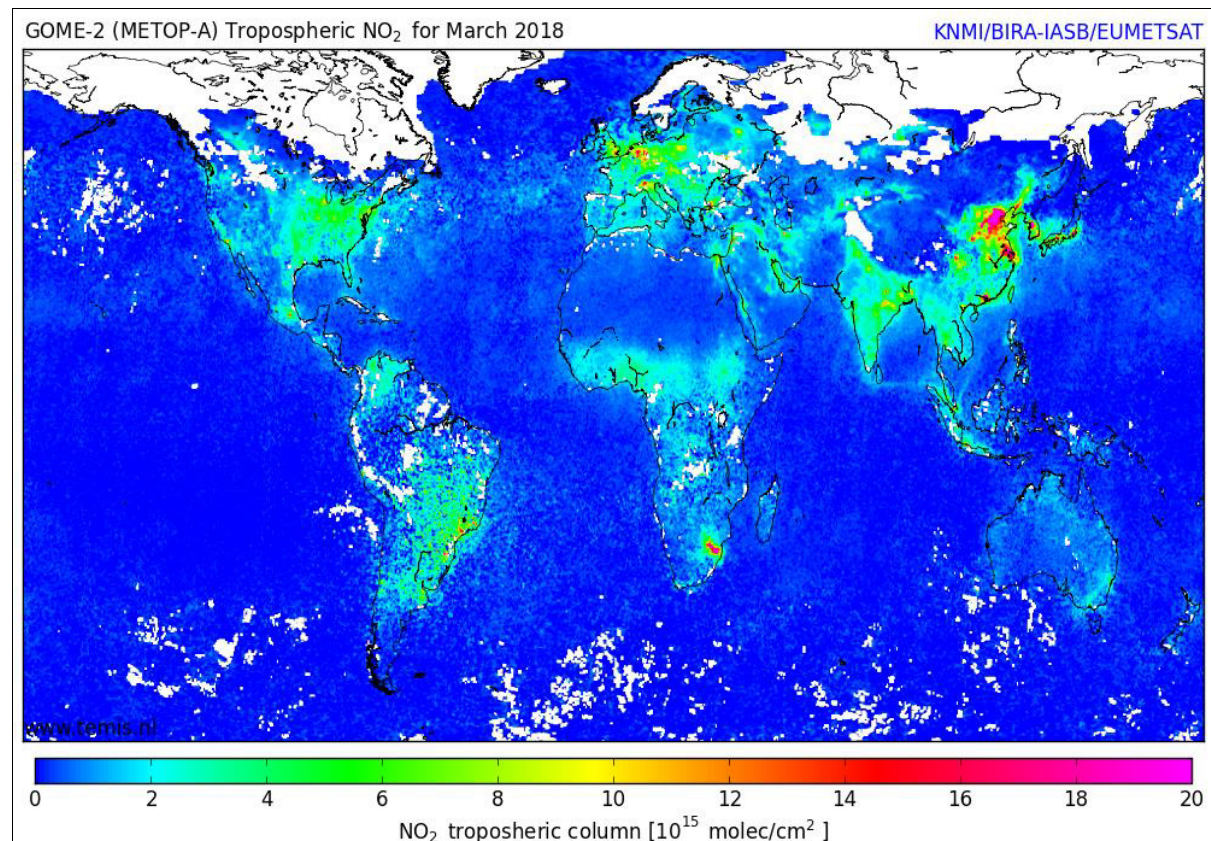
column density in 10 15 molecules/cm 2 for March 2018. 2